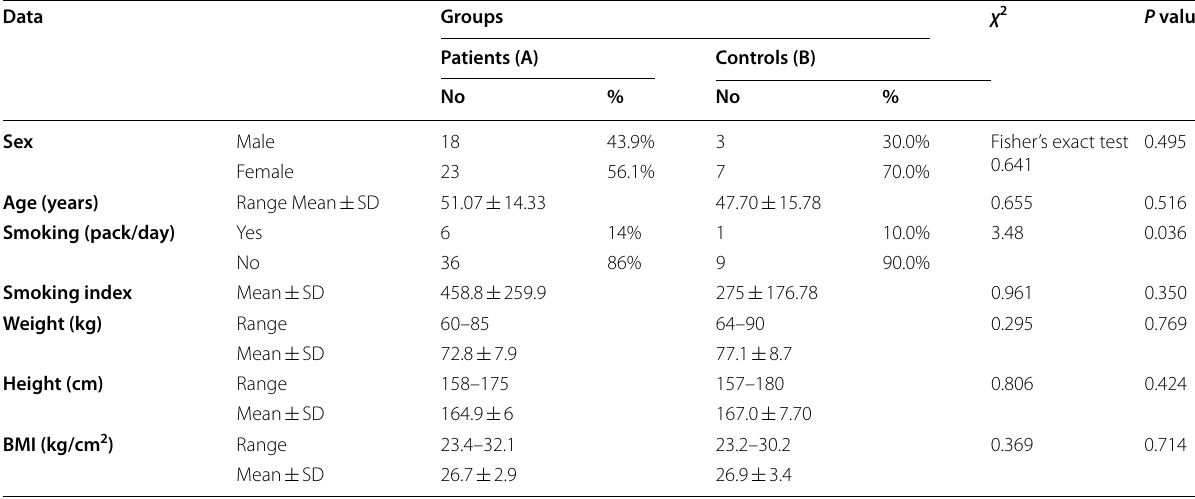
Table 1 The data of the studied groups